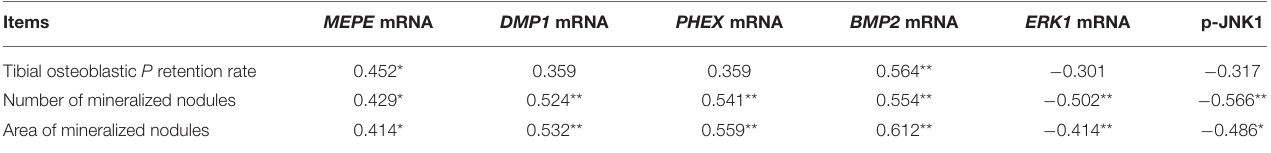
a Data represent the correlation coefficients between P utilization parameters and local bone-derived regulators or BMP/MAPK pathway in primary cultured tibial osteoblasts of broiler chicks, n =